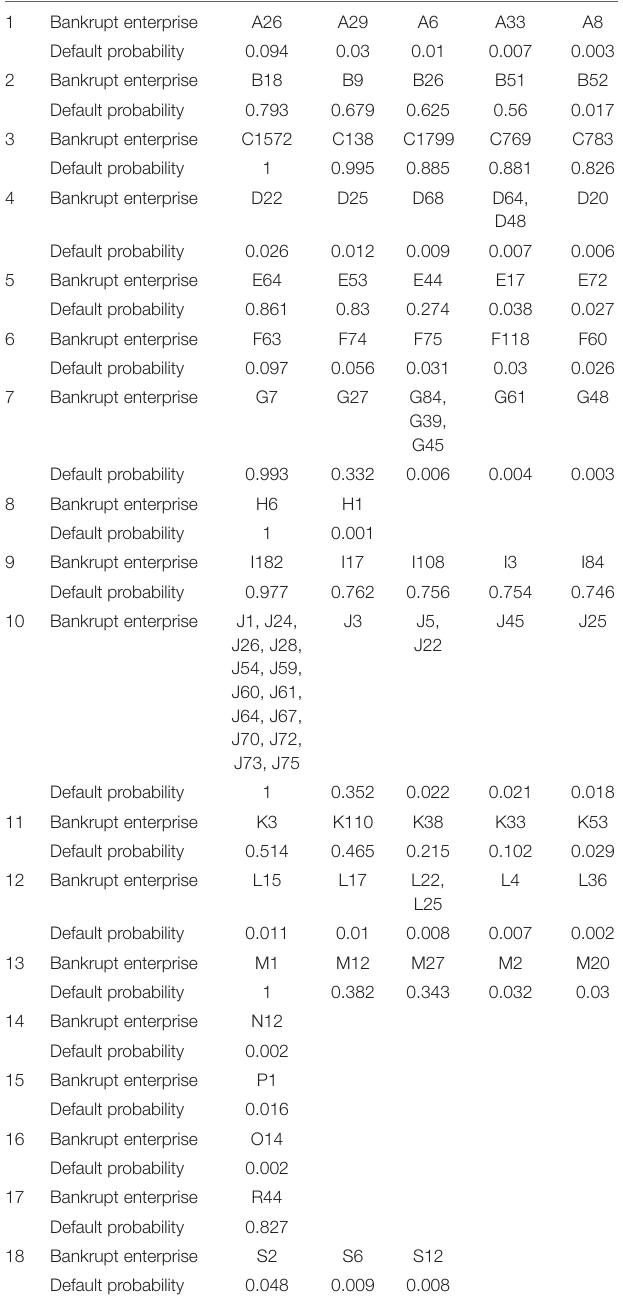
TABLE 2 | Listed companies with the top five bankruptcy frequency in the real industry.